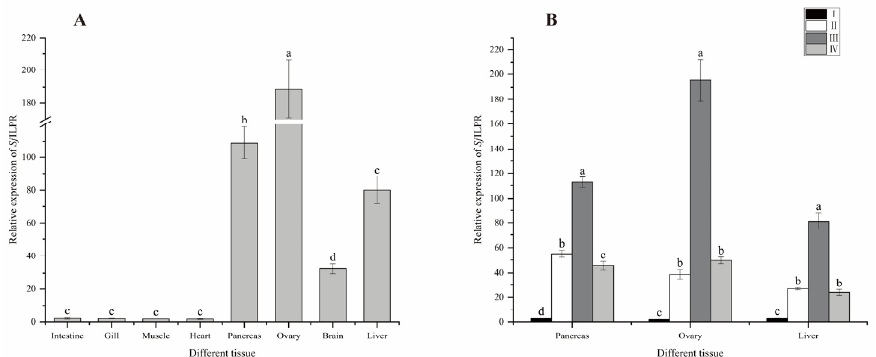
Figure 5. Expression of SjILPR in different tissues and ovarian development stages. Relative ex- pression of SjILPR is quantified and compared between different tissues ( A ). Expression levels of SjILPR in the ovary, pancreas, and liver tissues during ovarian development stages are quantified. Comparison of SjILPR expression levels between different stages in these three tissues ( B ). The results are expressed as mean ± SD (n = 7). Mean with different letters indicates significance ( p < 0.05).